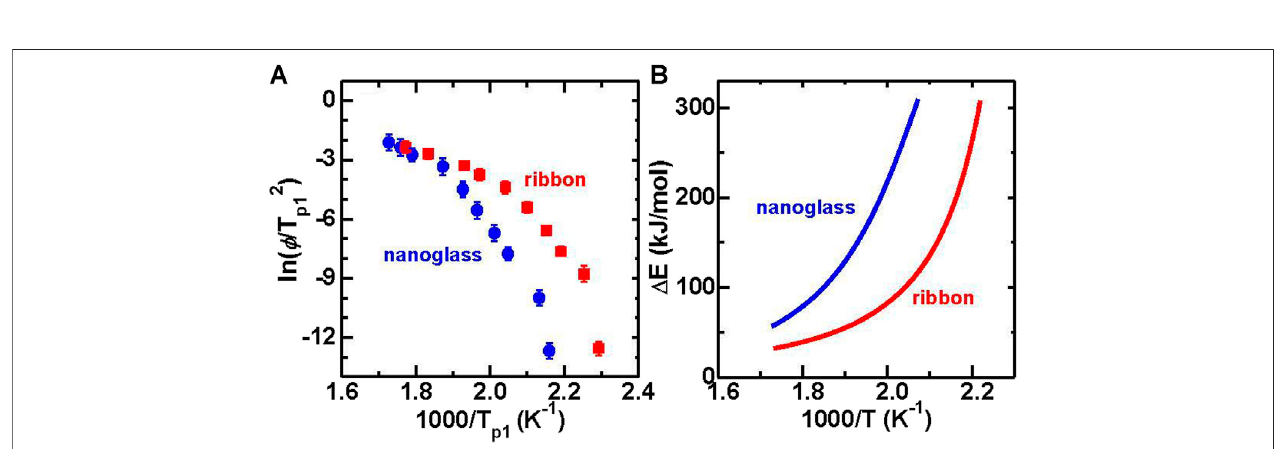
FIGURE 20 | (A) Kissinger plot of Tp1 for both Au 52 Ag 5 Pd 2 Cu 25 Si 10 Al 6 ribbon and nanoglass samples. (B) Crystallization activation energy with temperature by fi tting the Kissinger plot in Figure 20A (from (Wang J. Q. et al., 2014)).